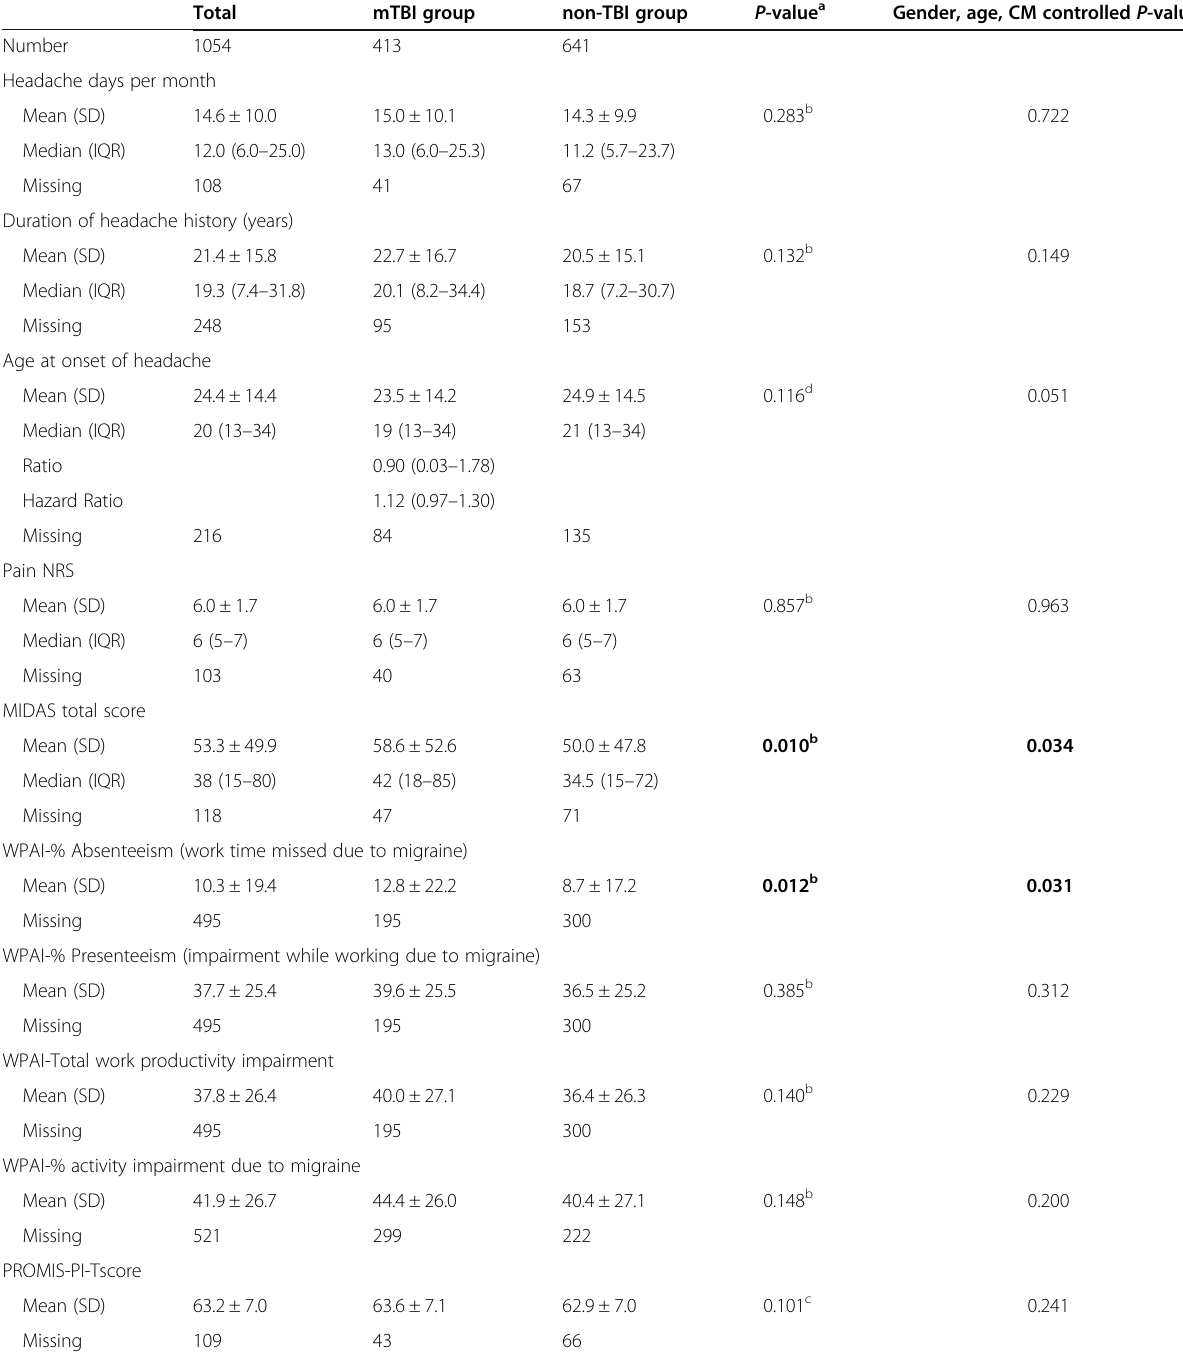
Table 5 Headache Characteristics, Disability, Anxiety and Depression Total mTBI group non-TBI group P -value a Gender, age, CM controlled P -value